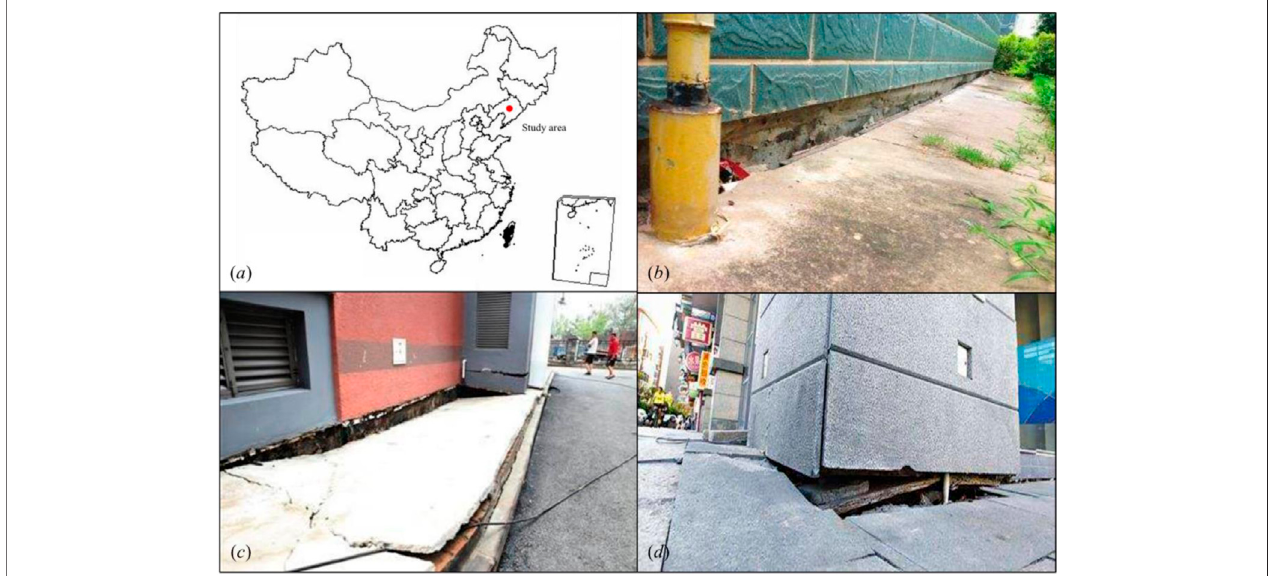
FIGURE 3 | Case study area and settlement examples.